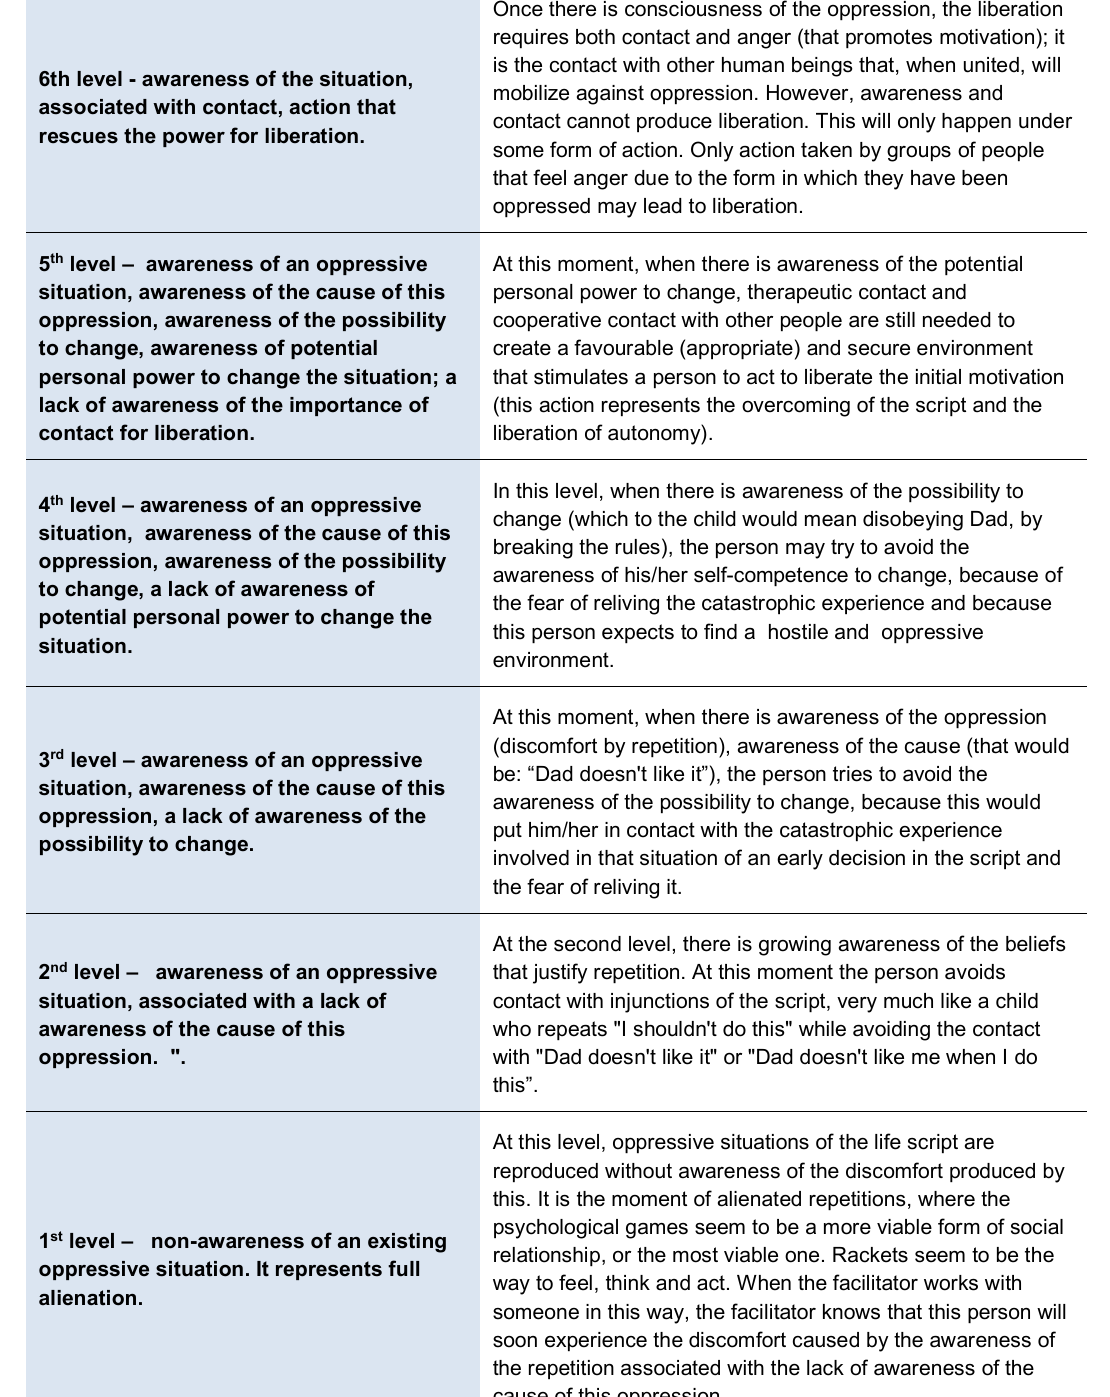
Figure 1: Levels of Consciousness of